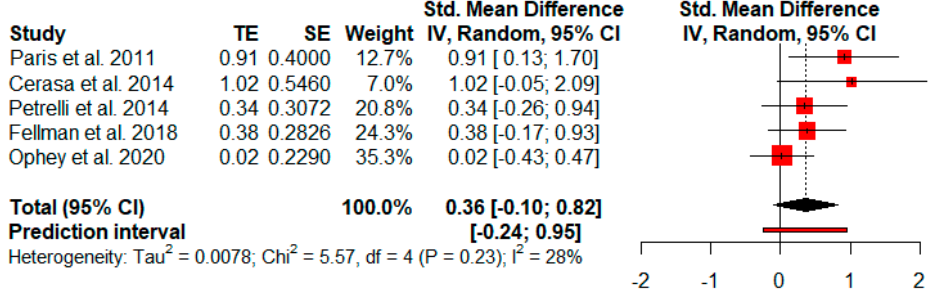
Figure 4 . Effectiveness of cognitive rehabilitation in attention.